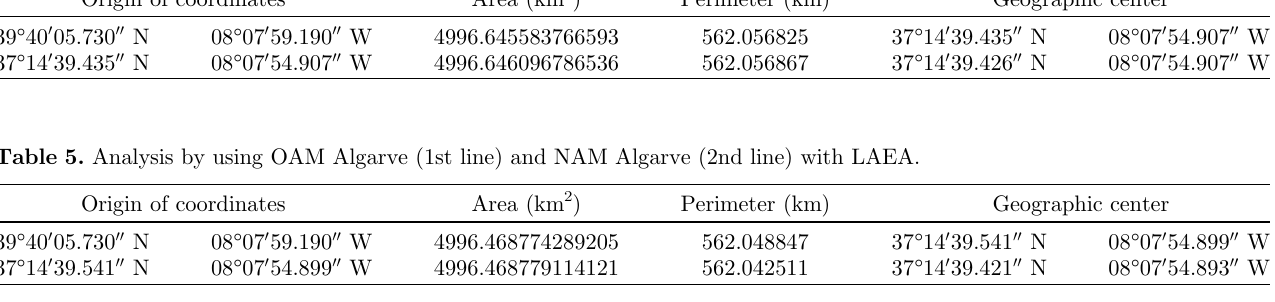
Table 4. Analysis by using OAM Algarve (1st line) and NAM Algarve (2nd line) with TMzn. Origin of coordinates Area (km 2 ) Perimeter (km) Geographic center